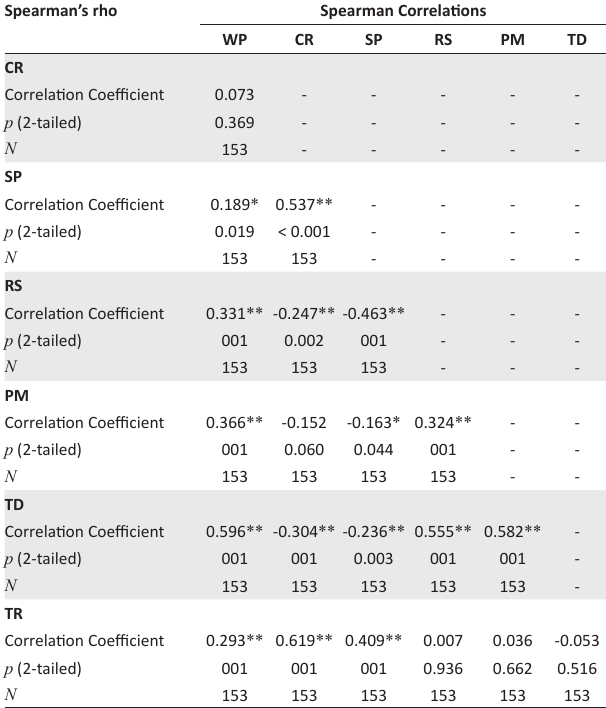
TABLE 3: Correlation analysis of the